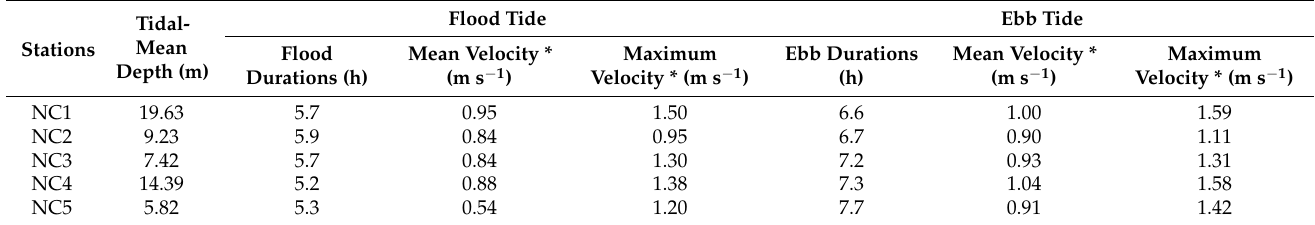
Table 1. Characteristic values of current velocity at NC1 to NC5